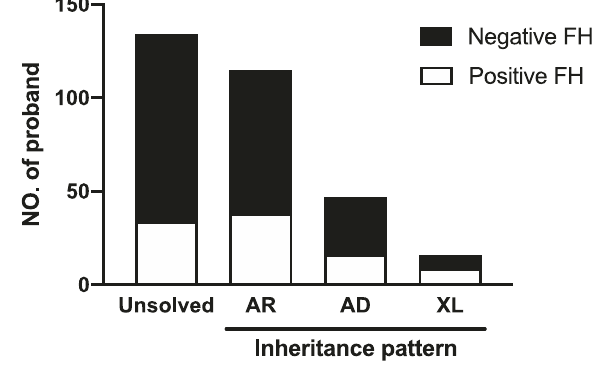
Fig. 2 Classi fi cation of the inheritance patterns of probands with a positive/negative family history. FH family history, AR autosomal recessive inheritance, AD autosomal dominant inheritance, XL X- linked